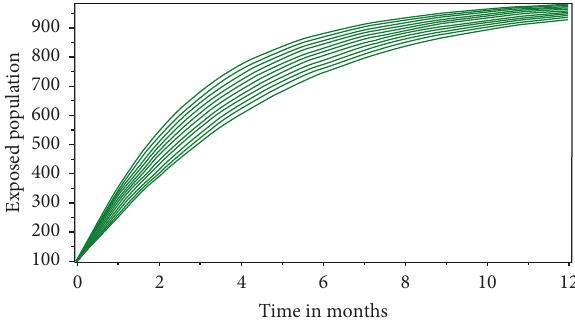
Figure 6: Approximate solution of exposed cows for ϕ �